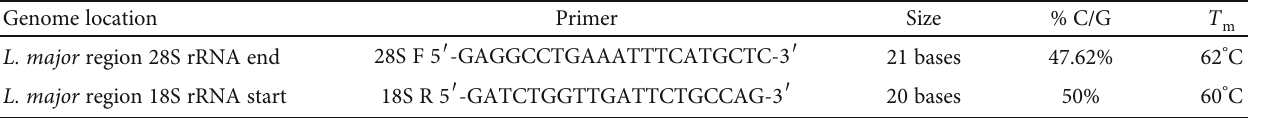
Table 2: Characteristics of primers designed for Leishmania spp. IGS rRNA region ampli fi cation.